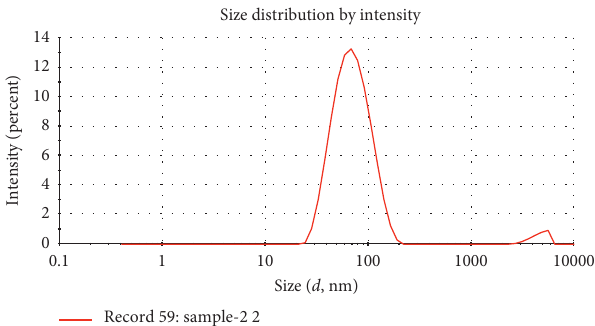
Figure 2: Droplet size distribution of DFS-NE (Z-average � 64.07nm with PdI � 0.238).